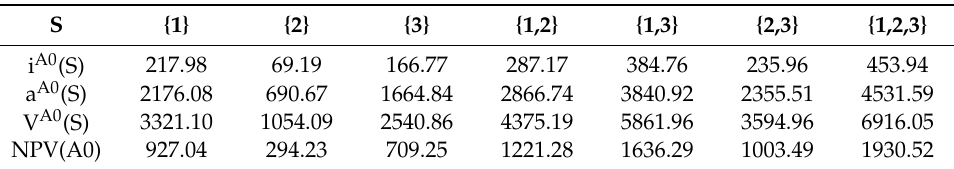
Table 22. Present values of cost and revenues games under Alternative A0.